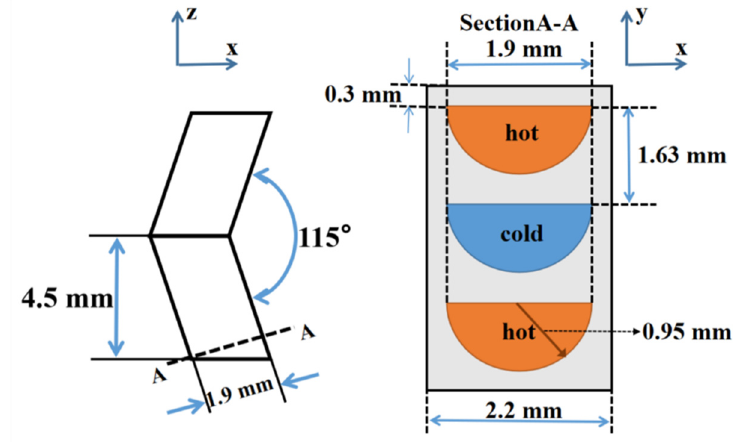
Figure 3. Diagram of the dimensions of the channel.